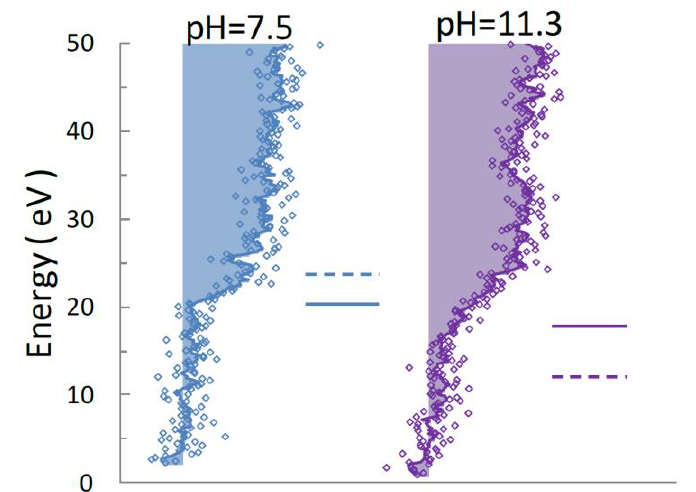
Figure 5. Electron spectra for aqueous UMP at pH = 7.5 and pH = 11.3 in the ionization energy of di-cations. For comparison, the theoretical double ionization potentials (DIPs) are shown by dashed and solid horizontal lines for isolated and hydrated Meura (model molecule for UMP), respectively (see text).